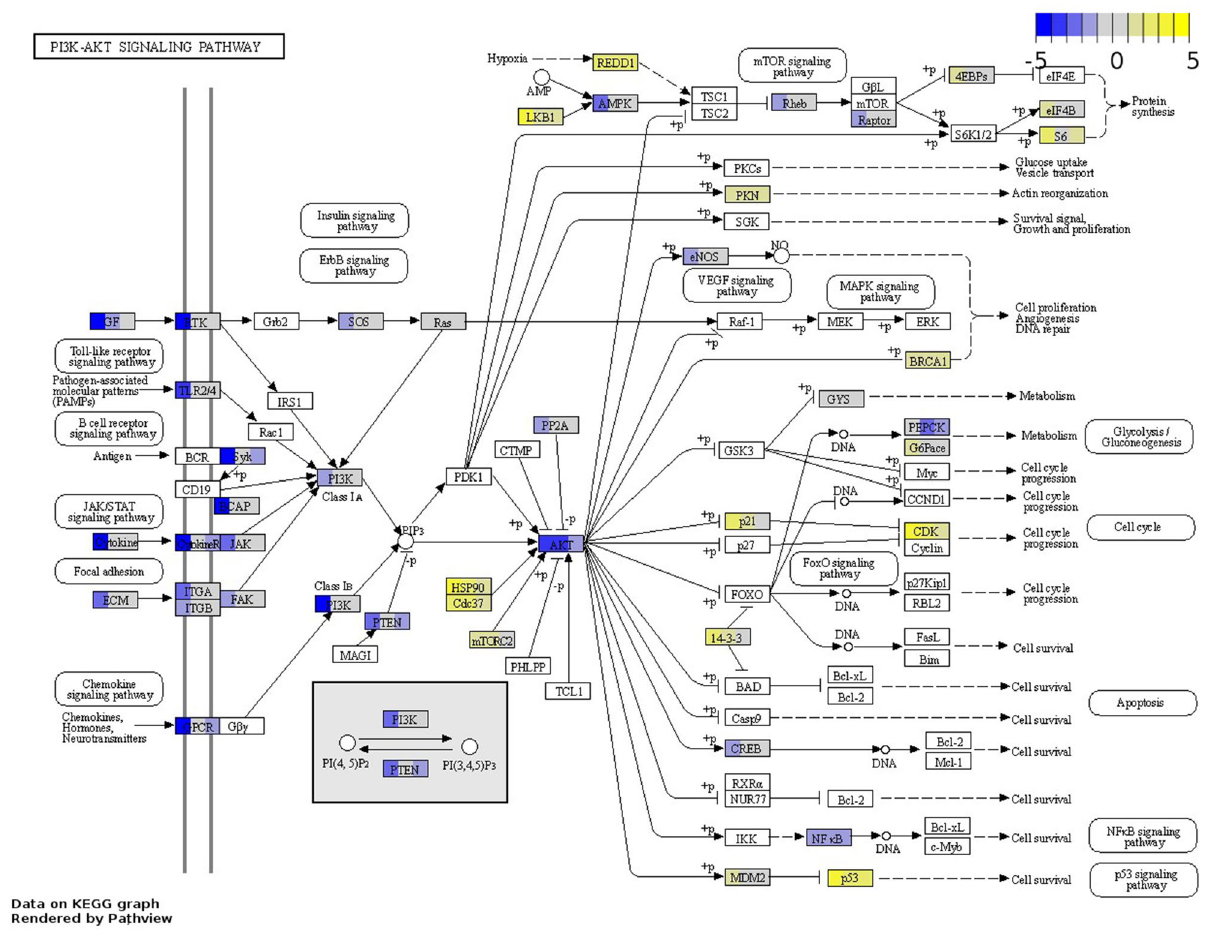
Figure 3. Differentially expressed genes enriching the PI3K-AKT signalling pathway (fca04151) in CLs, LB f HER2-, and normal-like TN tumours. The boxes illustrating DEGs are uniformly divided by the number of sample groups; representing from left to right: CLs, LB f HER2- tumours, and Normal-like TN tumours. Gene log 2 fold change relative to controls is indicated in yellow (upregulated) or blue (downregulated), white boxes represent genes not detected. Data on KEGG graph rendered by “Pathview” (https:// pathv iew. uncc.